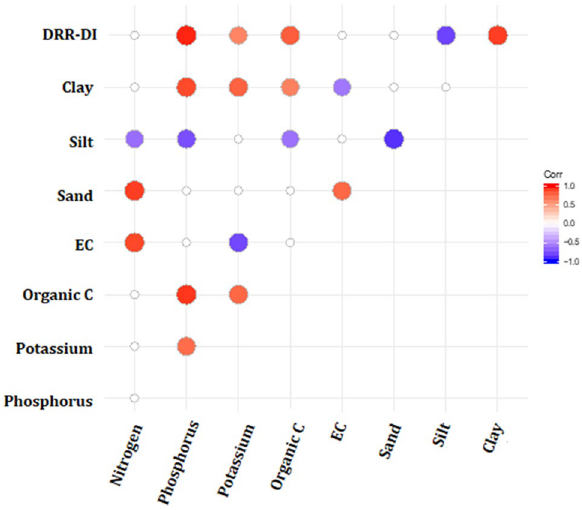
Figure 3. Correlation between DRR disease incidence and various edaphic factors. DRR disease incidence data from the field trial year 2018–19 and 2019–20 were analyzed for correlation (Pearson) with the edaphic factors for the respective trials. Red circles in correlation matrix represent significant positive correlation, and blue circles represent significant negative correlation, empty circles represent no significant correlation. Correlation with p < 0.05 was taken as statistically significant. Data used for the analyses along with correlation matrix with p- value is in Supplementary Table S3. DRR-DI = DRR disease incidence, EC = electrical conductivity of soil, organic C = organic carbon of